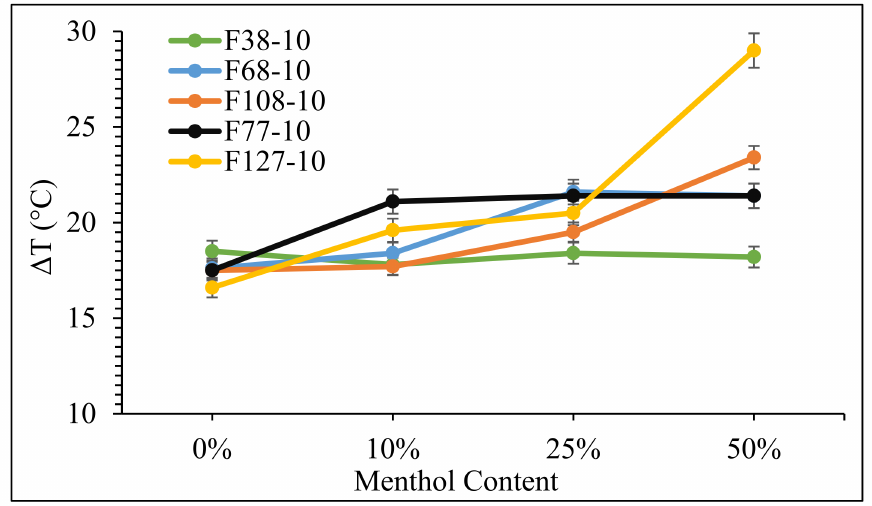
Figure 4. Melting point depression ( ∆ T) in Pluronics at 10 MPa in scCO 2 as a function of menthol content. In general, there was an increase in the extent of T m depression for all polymers which was highest for F127 with 50 wt% of menthol at 10 MPa. This is attributed to the comparatively high polarity of the scCO 2 –menthol solution compared with that of CO 2 alone and the resulting ease with which the menthol and CO 2 molecules interact with the polymer [5]. Notably, both Pluronic F77 and F127 melted at room temperature (25 ◦ C) with 25% and 50 wt% additions of menthol, respectively. Polymers with comparatively greater PPO fractions (F77 and F127 with ~30% PPO) showed a higher depression in T m with increasing menthol content in scCO 2 in comparison to those with lower PPO fractions of ~20% (F38, F68, and